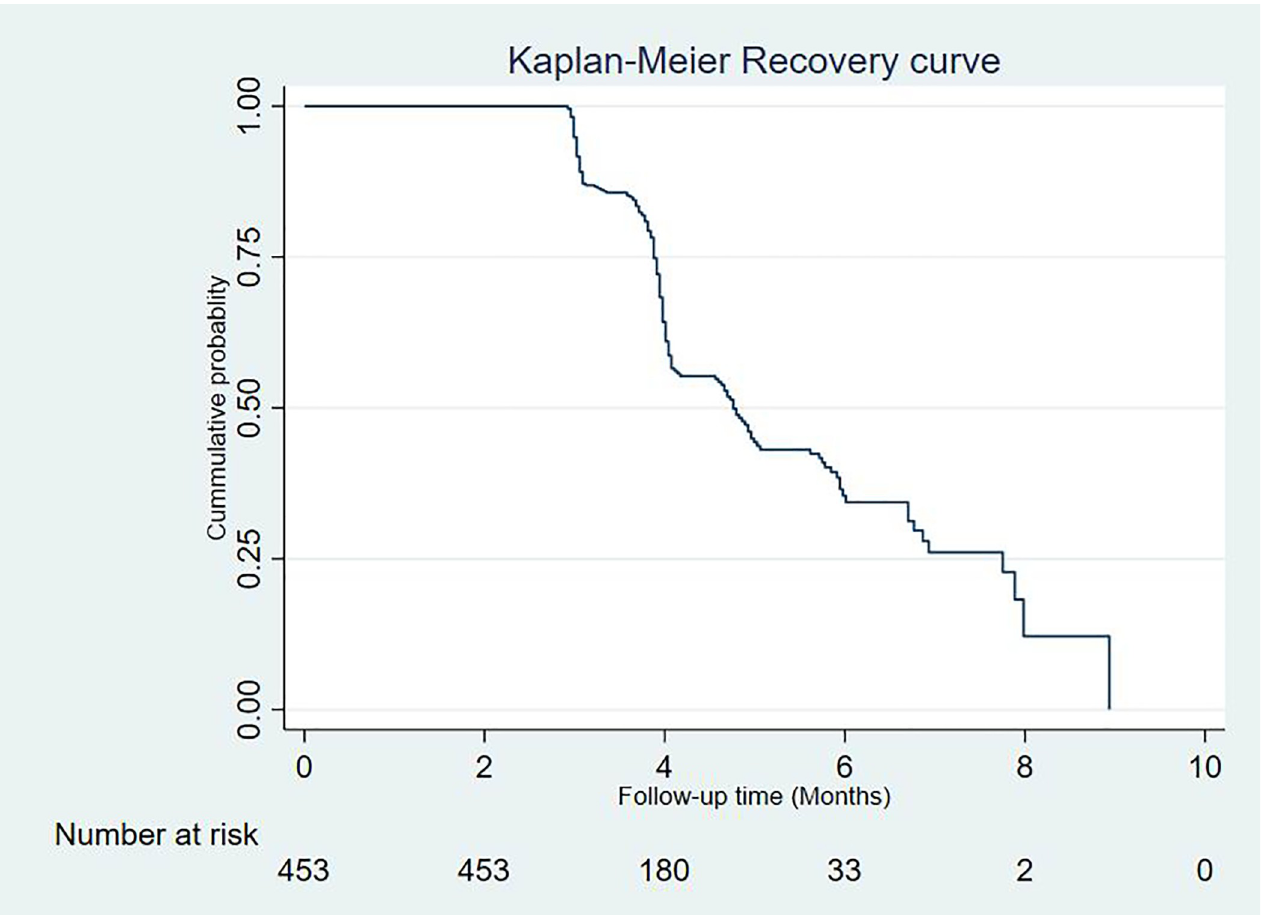
Fig 1. The overall Kaplan-Meier recovery curve with 95% confidence interval of under nourished HIV positive adults treated with RUTF at Debre Markos Referral Hospital from July 1 st , 2015 –December 31 st ,